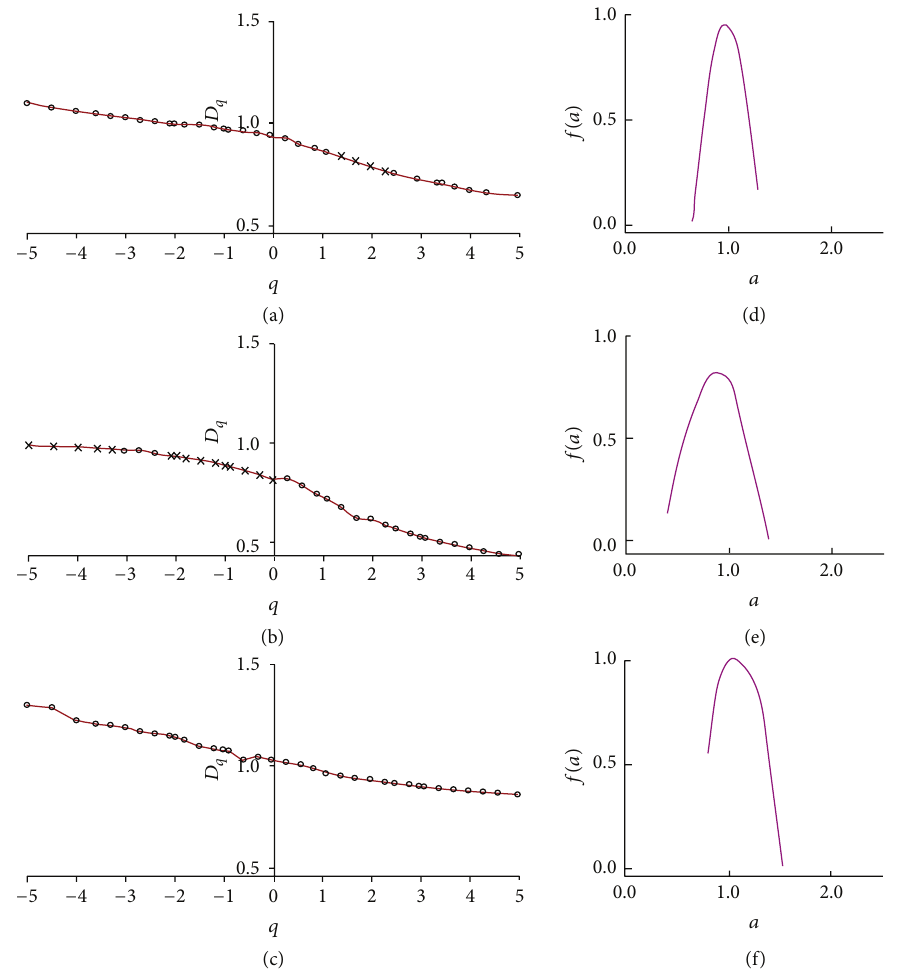
Figure 3: The three variation stages of the generalized dimension spectrum and singularity spectrum before and after 21 May 1984 Wunansha earthquake (M6.2). (a) and (d) show the generalized dimension spectrum and singularity spectrum two years prior to this earthquake, respectively; (b) and (e) show the generalized dimension spectrum and singularity spectrum eight months prior to this earthquake, respectively; (c) and (f) show the generalized dimension spectrum and singularity spectrum ten months after this earthquake, respectively. The curve of the generalized dimension spectrum in Figure 3(b) is steeper than the two others, and the value range of the singularity spectrum in Figure 3(e) is broader than the two